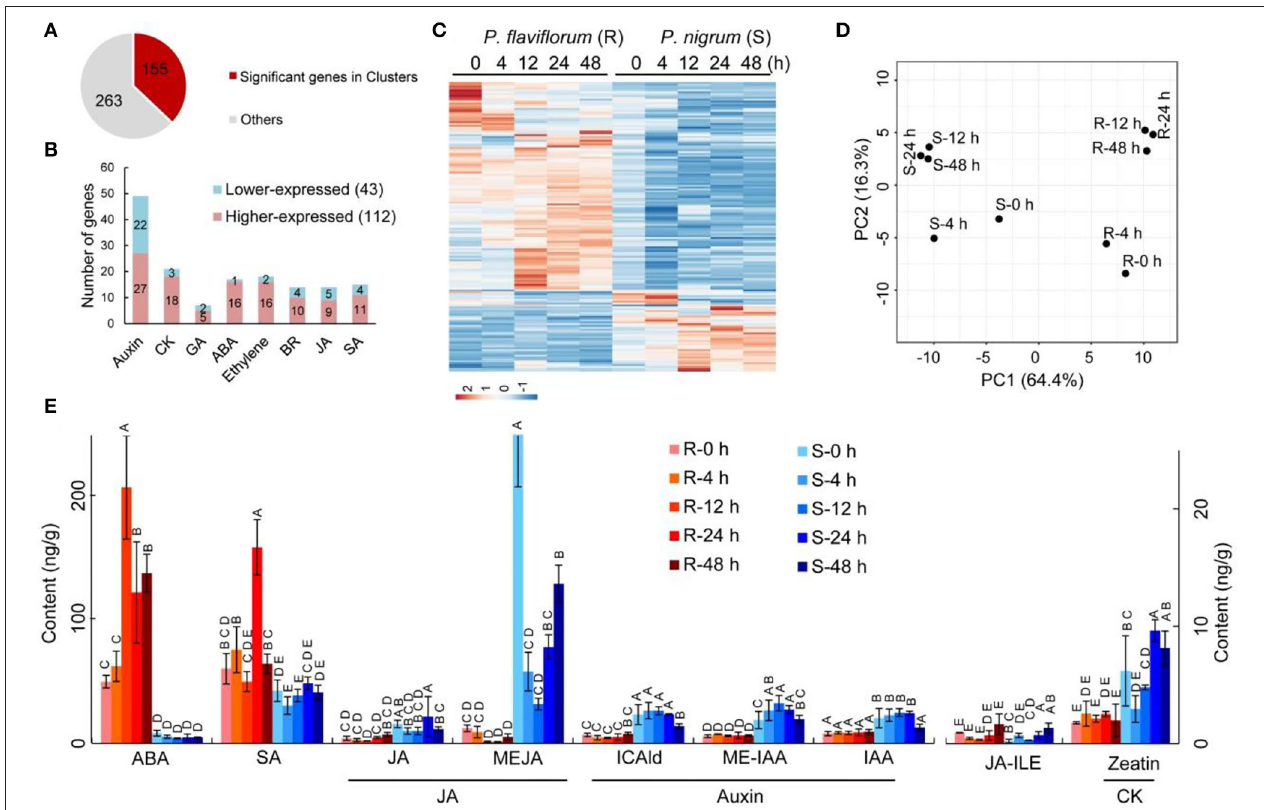
FIGURE 3 | Time-course-dependent accumulation of ABA and SA and patterns of differential expression for genes involved in phytohormone signaling and response in resistant Piper (R; P. flaviflorum ) upon P. capsici inoculation. (A) Number and proportion of differentially expressed genes relative to all putative genes involved in phytohormone signaling. (B) Pathway distribution of the 155 differentially expressed genes involved in plant hormone signal transduction. Red color indicates higher and blue color indicates lower relative expression in resistant Piper compared with susceptible Piper . (C) Heatmap of genes from (B) . (D) Principal component analysis plots of significant cluster genes involved in plant hormone signal transduction, based on RNA-seq data. For clarity, each dot represents the average expression from three replicates. (E) Time-course LC-MS/MS evaluating the plant hormone content of root samples at 0, 4, 12, 24, and 48 hpi, including abscisic acid (ABA), salicylic acid (SA), jasmonates (JA), auxins, and cytokinin